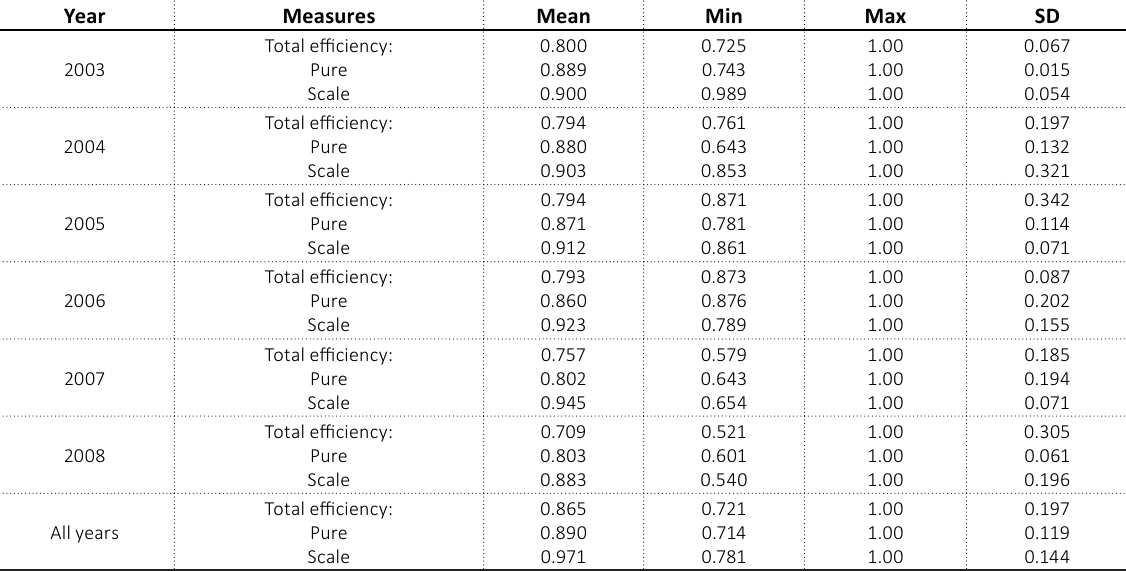
Table 5. Measures of efficiency of conventional banks with Islamic windows before the crisis